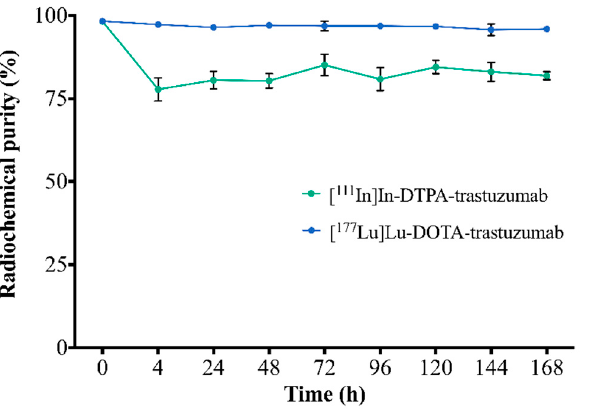
Figure 2. Assessment of the stability of RICs in serum by ascending chromatography. Values are expressed as mean ± SD ( n = 6).